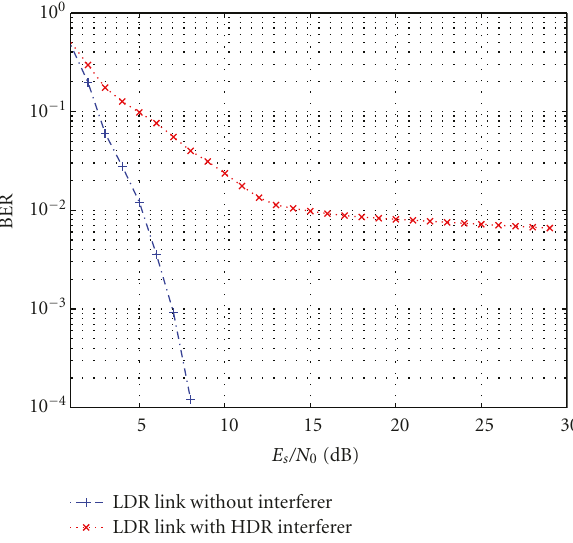
Figure 7: Mutual interference e ff ects of an ECMA-368 interferer on an IEEE 802.15.4 link. The distance between the interferer and the intended receiver is set to 10